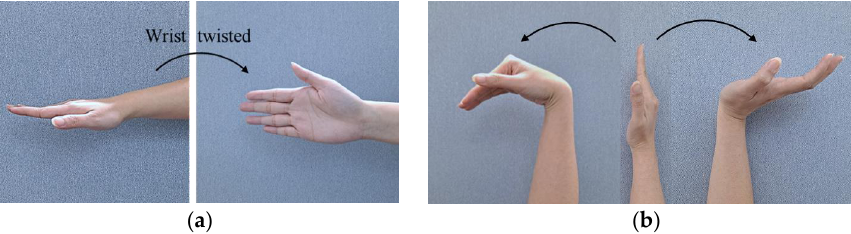
Figure 7. Wrist twist assessment: ( a ) wrist is twisted in mid-range (pronation – supination); ( b ) wrist is at or near the end of range.